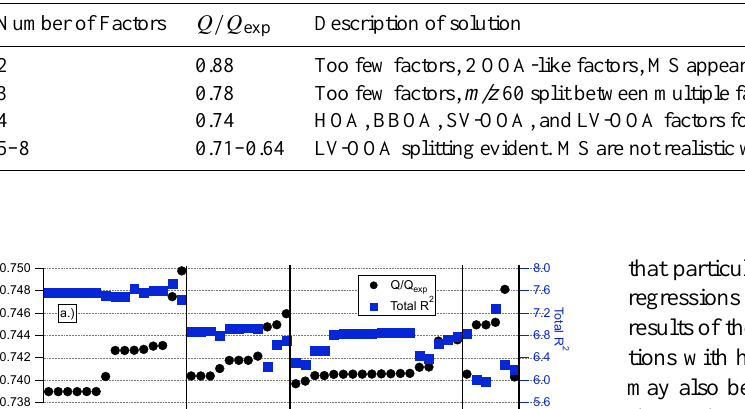
Table A1. This table describes the reasons for the choice of the 4 factor PMF solution.